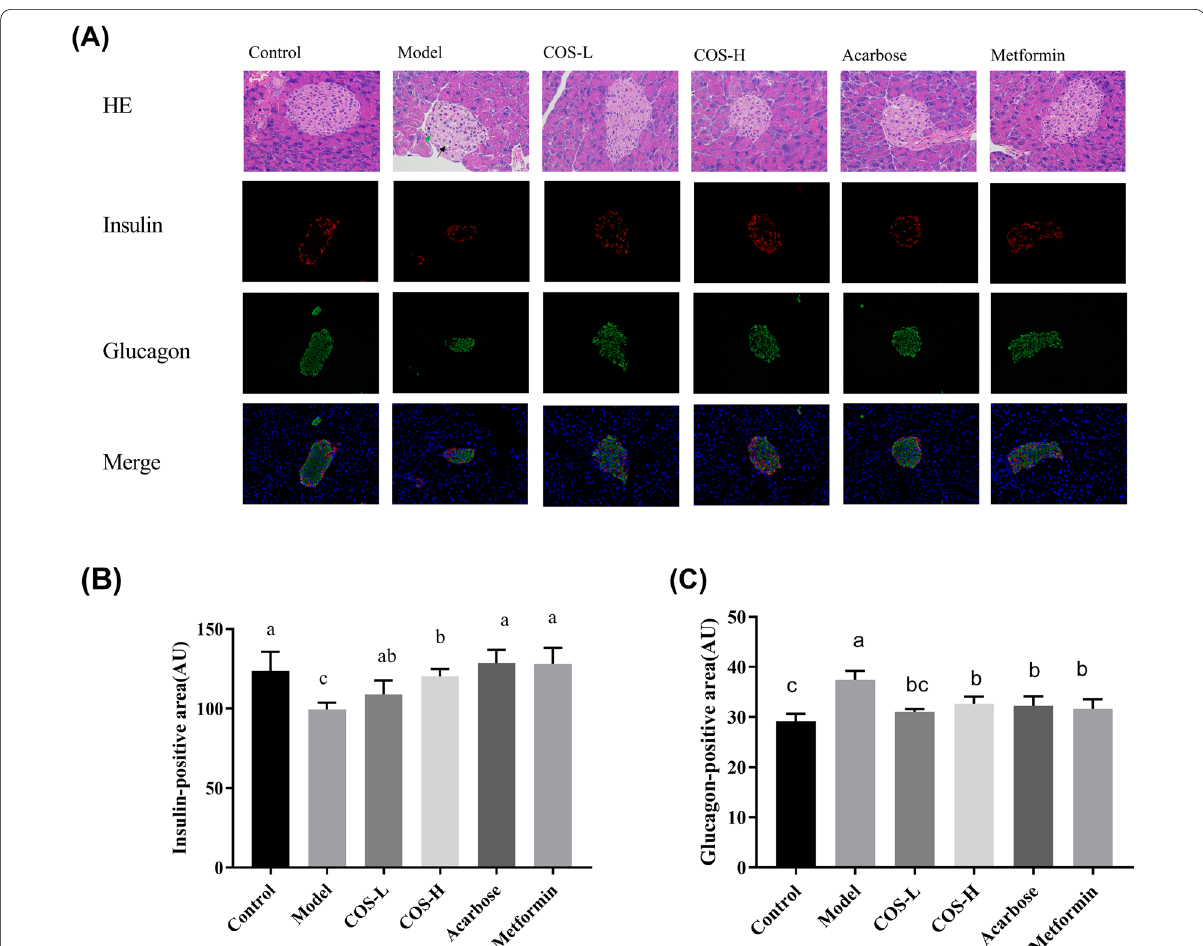
Fig. 7 The A HE and immunofluorescence staining of the mouse pancreas and the fluorescence intensity of the B insulin and C glucagon in the pancreas of the